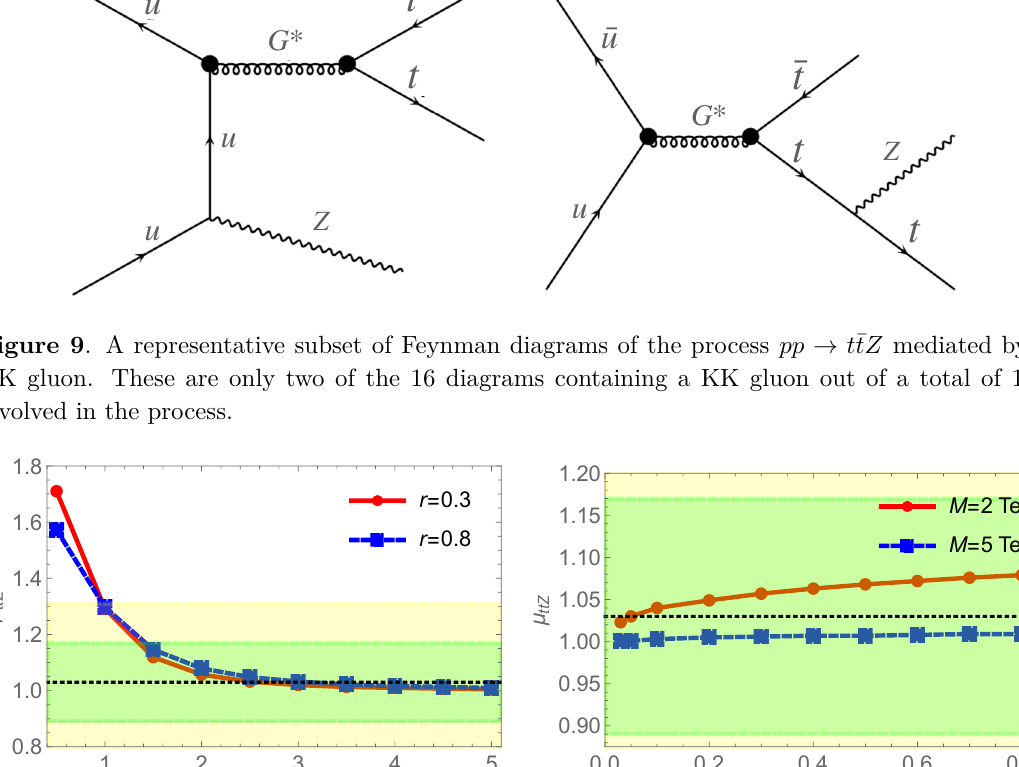
, as a Figure 10 . Ratio of the total cross-section pp → t ¯ tZ with respect to the SM value, µ th t ¯ tZ function of the renormalized on-shell mass M (left panel) for the fixed ratios r = 0 . 3 (red solid line) and r = 0 . 8 (blue dashed line), and as a function of the ratio r (right panel) for the fixed masses M = 2 TeV (red solid line) and M = 5 TeV (blue dashed line). The different lines correspond to the predictions based on the full propagator (pole approach), while the bands represent 1 σ (light green) and 2 σ (light yellow) deviations from the µ obs central value (black dotted line) observed t ¯ tZ